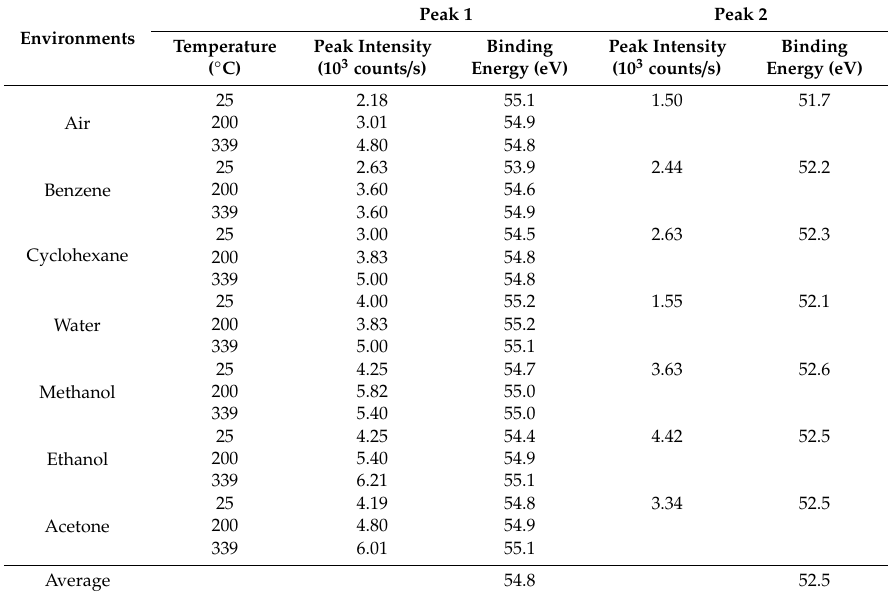
Table 2. The intensities and binding energies of Peaks 1 and 2 observed in Fe 3 p spectra at three temperatures for iron surfaces scratched in di ff erent temperatures for iron surfaces scratched in different environments.